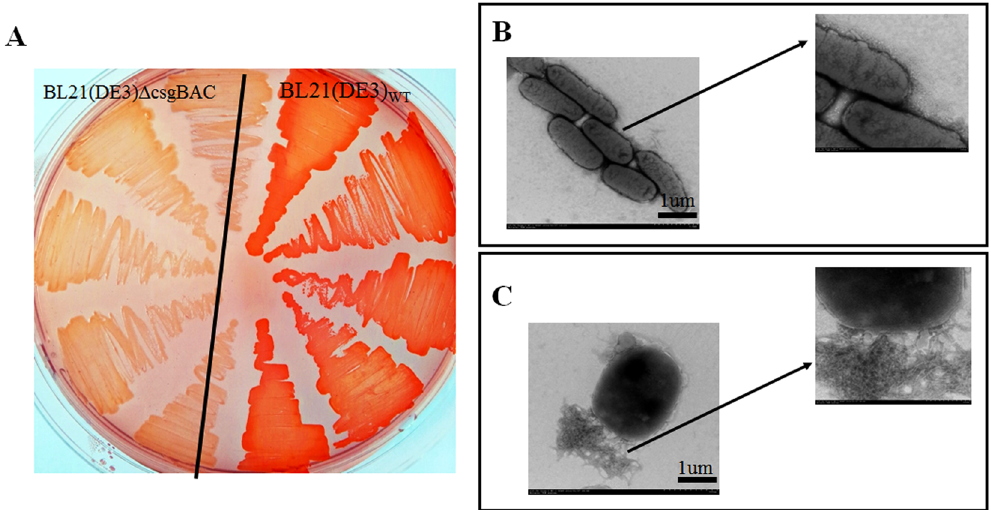
Figure 3. Phenotype of BL21 (DE3) WT and BL21 (DE3) ∆ csgBAC after growth on a YESCA plate. ( A ) BL21 (DE3) WT and BL21 (DE3) ∆ csgBAC were cultured on YESCA-Congo red indicator plates at 25 °C for 3 d. Red staining indicates amyloid production. BL21 (DE3) ∆ csgBAC appeared white, which indicates that this strain may have lost the ability to produce curli fibers. Transmission electron microscopy (TEM) analysis of BL21 (DE3) ∆ csgBAC ( B ) and BL21 (DE3) WT ( C ) after cultivation on YESCA plates at 25 °C for 3 d showed that abundant curli fibers were synthesized by BL21 (DE3) WT , whereas no fibers were observed on BL21 (DE3) ∆ csgBAC , indicating that the latter was indeed a curli-deficient mutant. The scale bars represent 1 µ